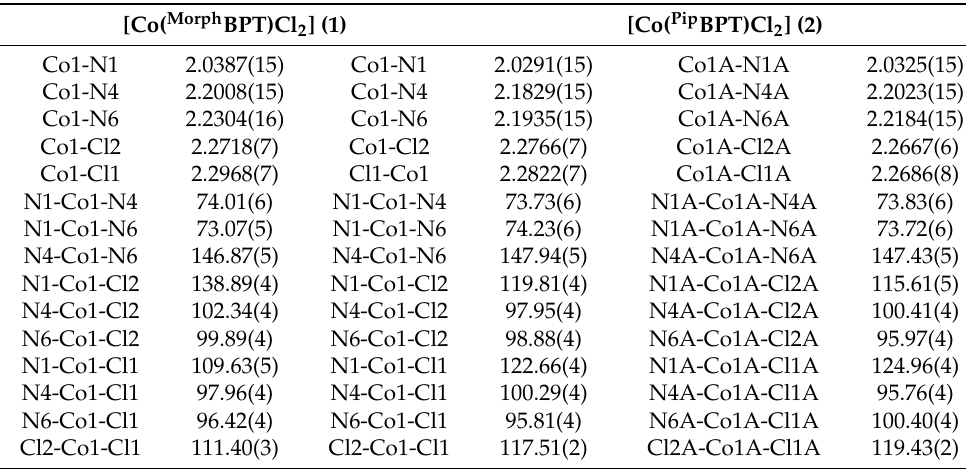
(Table 3). Packing of complex units via C-H . . . Cl and C-H . . . O interactions is shown in Figure 3 (lower